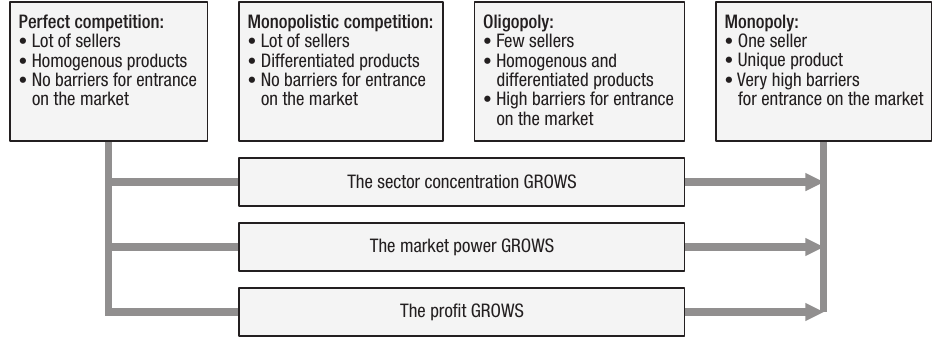
Fig. 1. Competition, concentration and profi